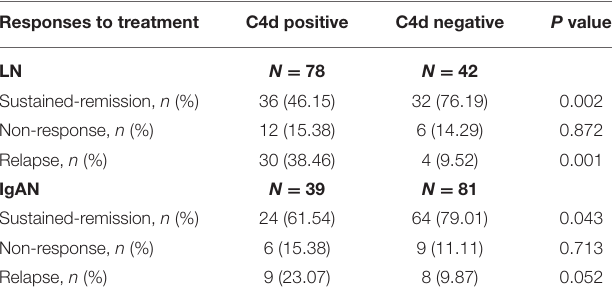
TABLE 4 | Relationship between renal C4d deposition with responses to treatment of LN and IgAN patients. Responses to treatment